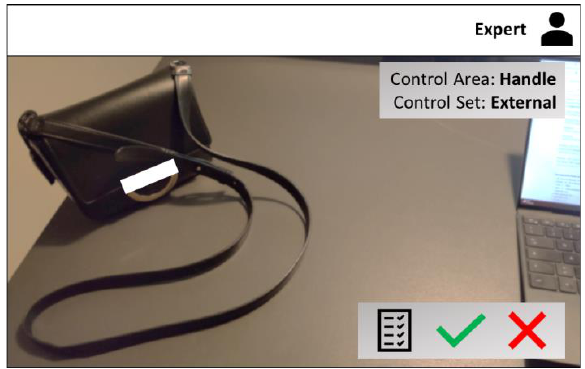
Figure 4. Expert view per Control area, Control set (grey areas display the overlayed suggestions).